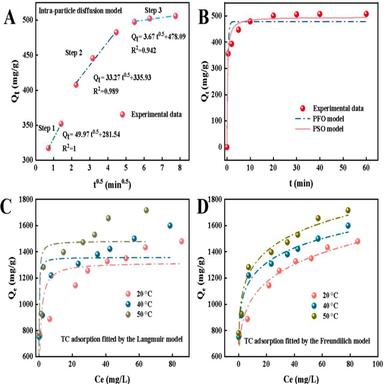
(A–B) Adsorption kinetics of TC on CK3–800. Equilibrium isotherms of TC adsorption fitted by the Langmuir (C) and Freundlich models (D) at different temperatures (20 ℃, 40 ℃, and 50 ℃).